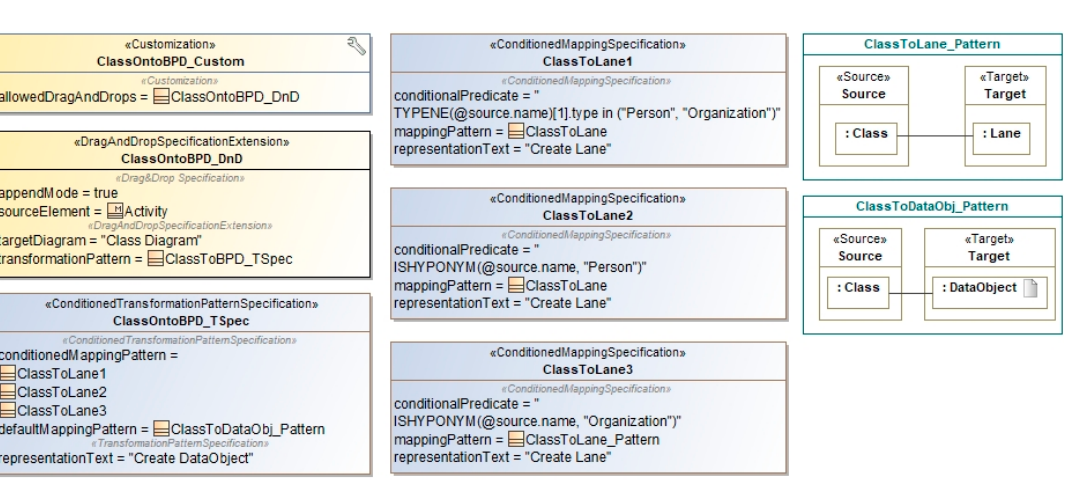
Figure 10. M2M transformation specification for UML Class to BPMN Process model transformation.